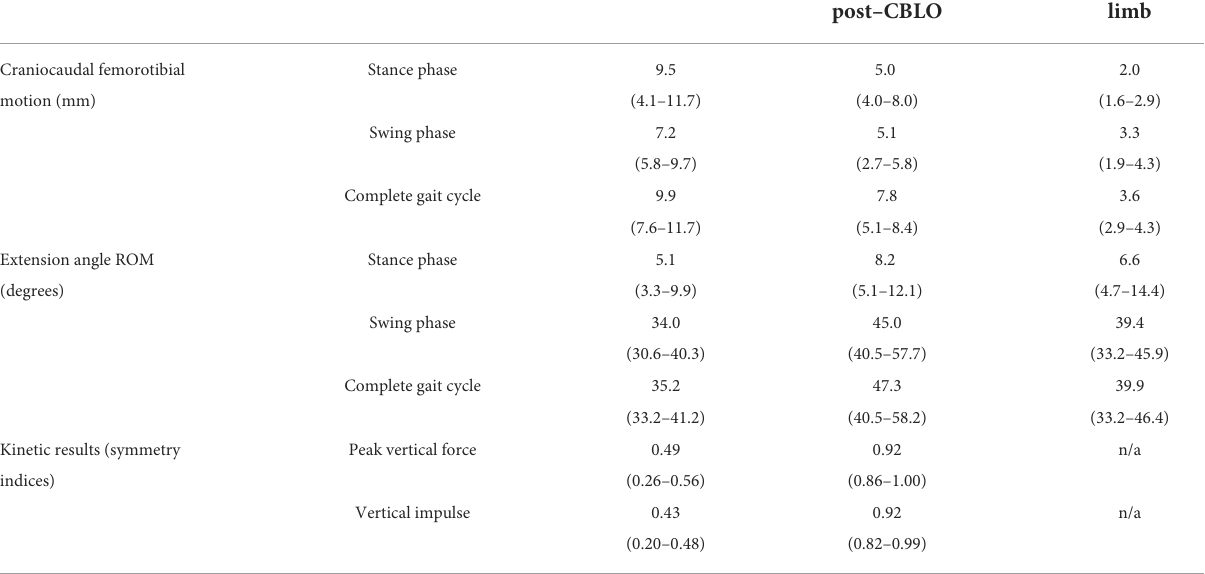
TABLE 1 Kinematic and kinetic results [median